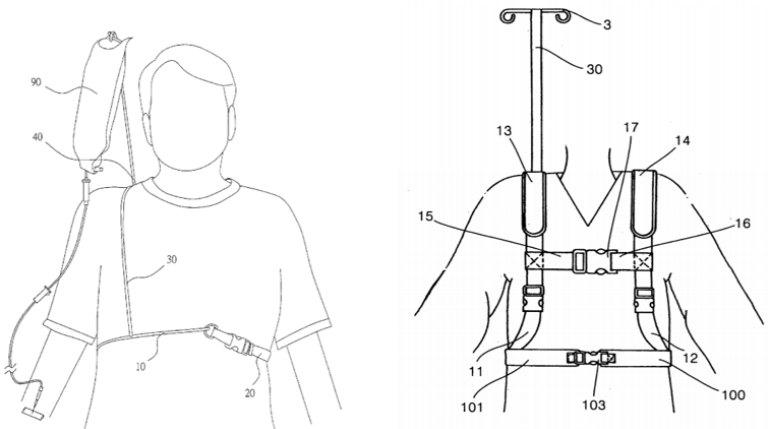
Table 1. Comparison of drip frame technologies.